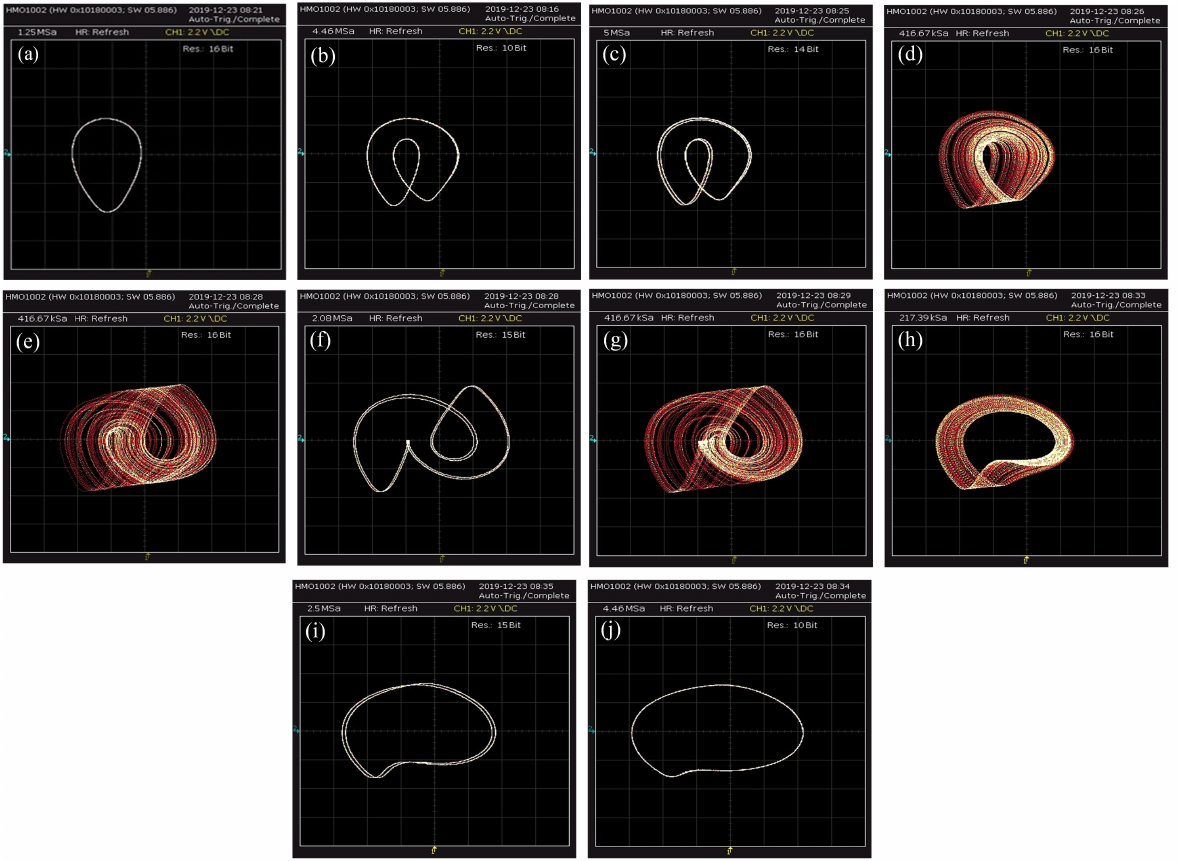
Figure 7. Experimental observation of υ C versus υ C , of ( a ) period-1 phase portrait for R b = 50 k Ω ( b = 0.2), ( b ) period-2 phase 2 1 portrait for R b = 40 k Ω ( b = 0.25), ( c ) period-4 phase portrait for R b = 38.16 k Ω ( b = 0.262), ( d ) chaotic phase portrait for R b = 38 k Ω ( b = 0.263), ( e ) chaotic phase portrait for R b = 25 k Ω ( b = 0.4), ( f ) period-2 phase portrait for R b = 19.05 k Ω ( b = 0.525), ( g ) chaotic phase portrait for R b = 14.3 k Ω ( b = 0.699), ( h ) chaotic phase portrait for R b = 11 k Ω ( b = 0.909), ( i ) period-2 phase portrait for R b = 10.1 k Ω ( b = 0.99), and ( j ) period-1 phase portrait for R b = 9.09 k Ω ( b = 1.1). The rest of parameters are a = 4 × 10 − 4 , c = 3.846 × 10 − 4 and d = e =